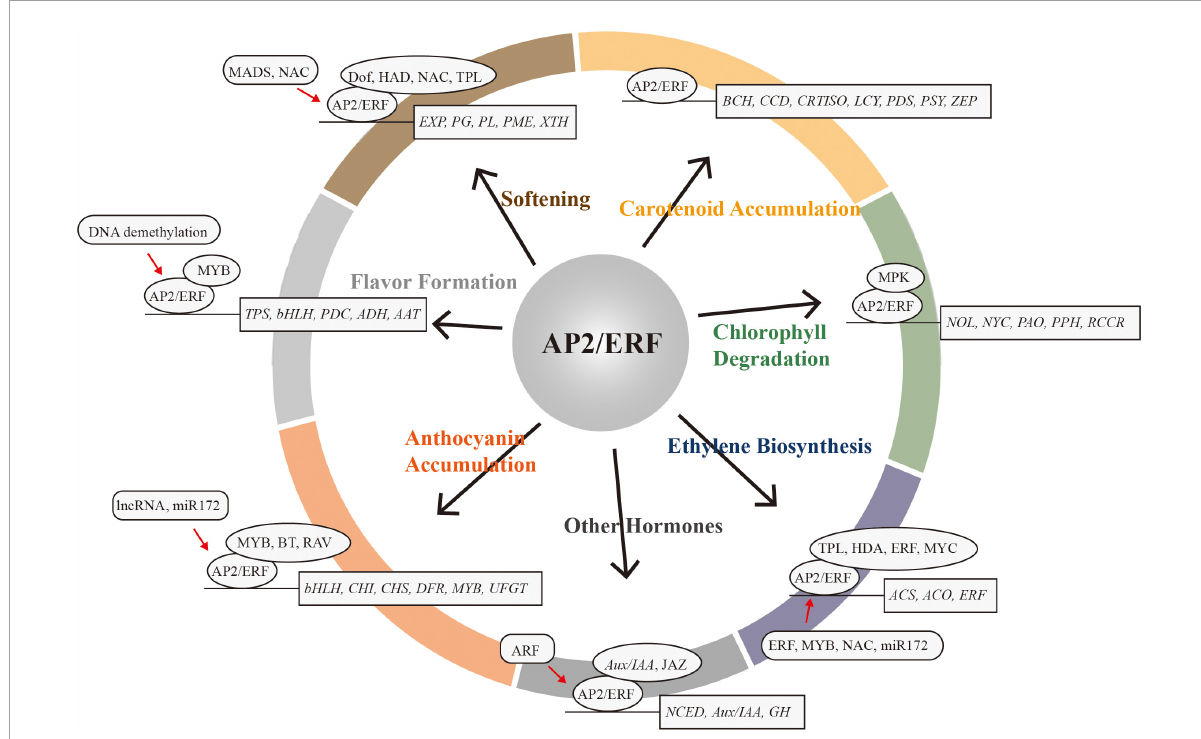
FIGURE2 The AP2/ERF superfamily acts as a critical regulator in fruit ripening. Target genes are in rectangles. Protein–protein interactions or co-regulators are in ovals. Red arrows represent expression regulation by